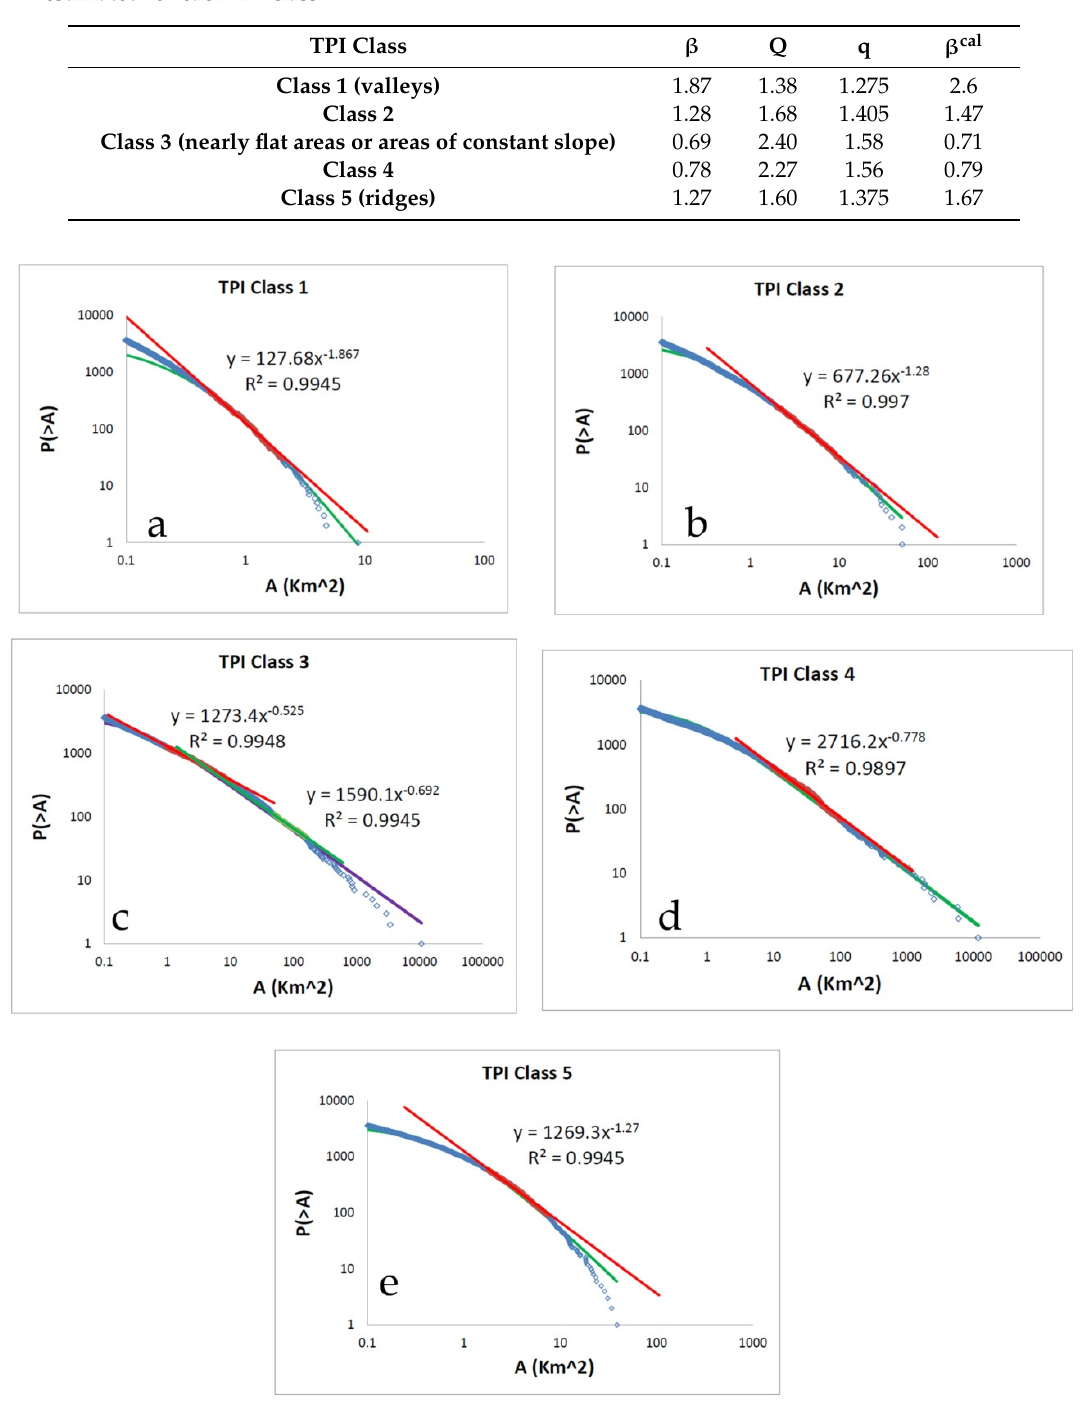
Table 2. The power law exponent β , the Q and q non extensive parameters and the β cal value as estimated for each TPI class.